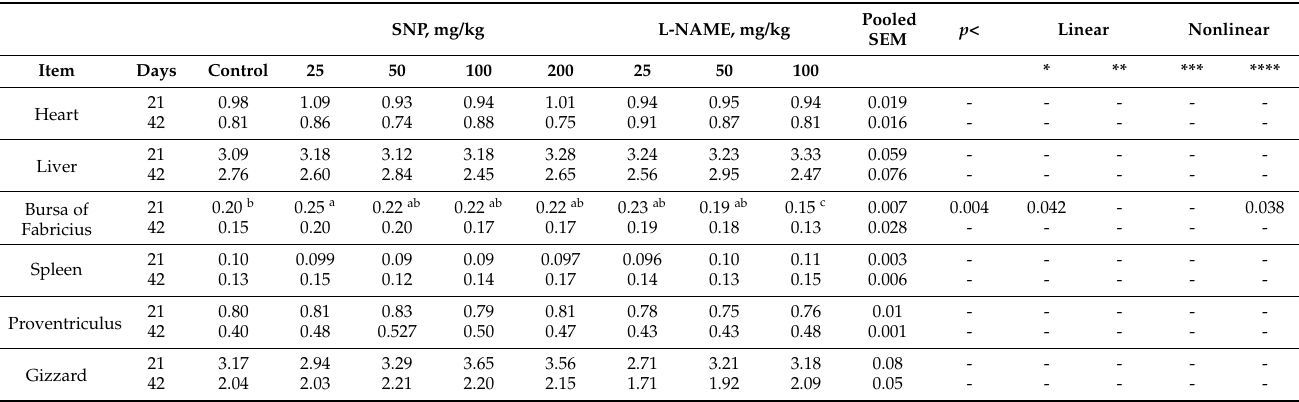
Table 3. Effect of dietary sodium nitroprusside (SNP) and N G -nitro-L-arginine methyl ester (L-NAME) supplementation on relative organ weights (%) on days 0–21 and 22–42.